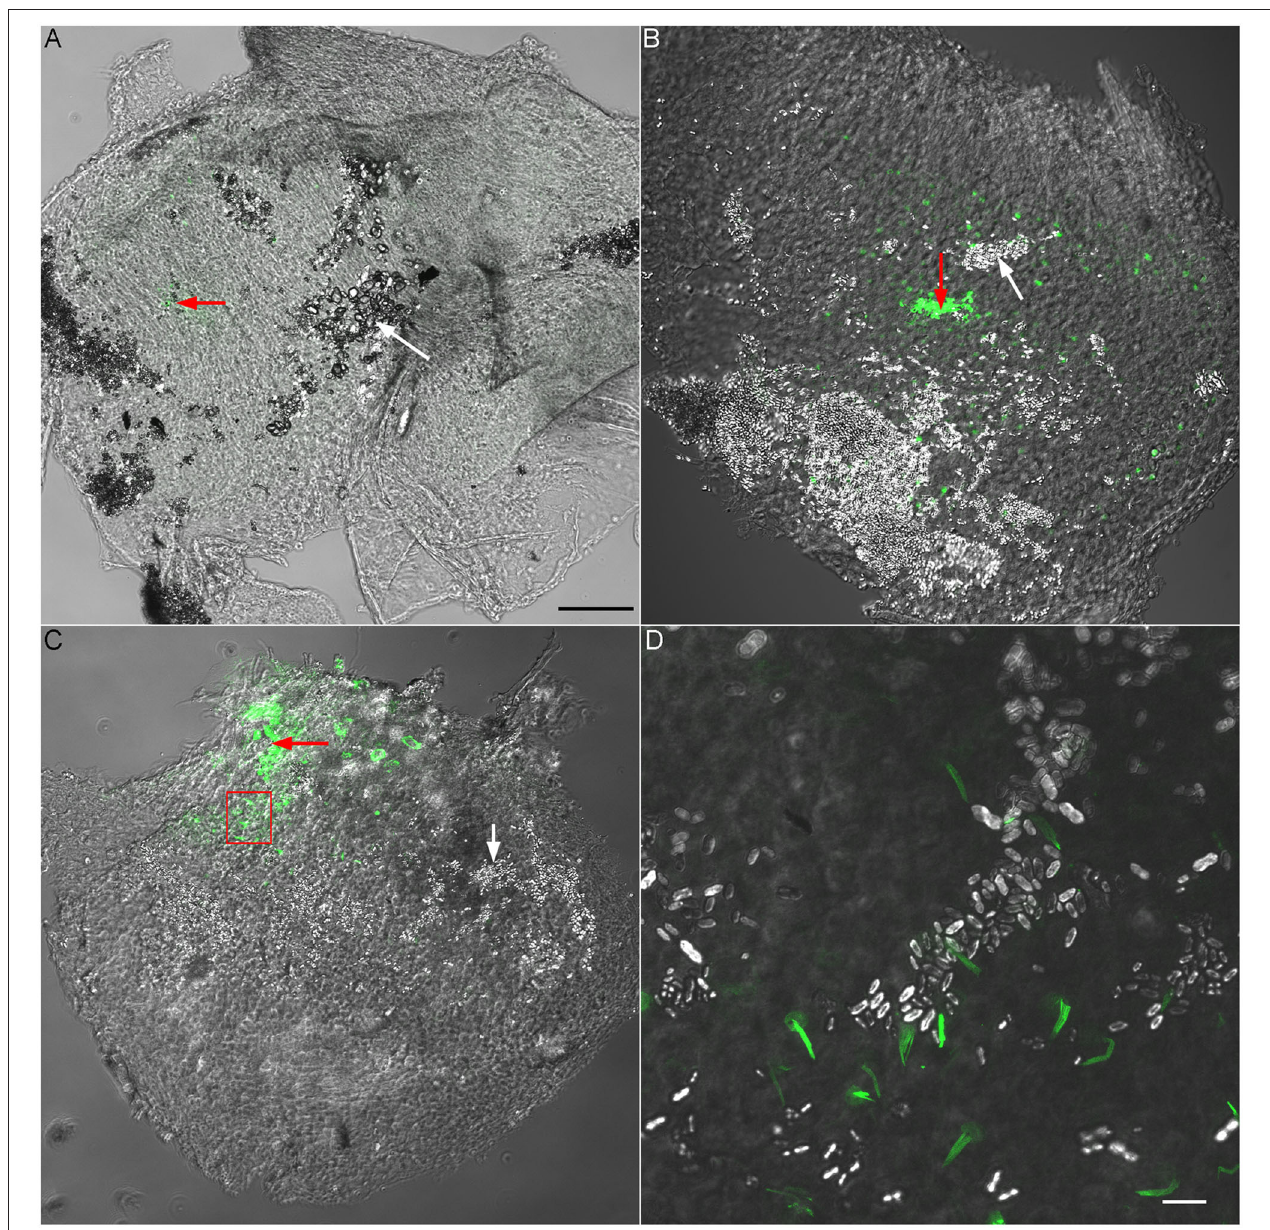
FIGURE 4 | Validation of recording site using fluorescent phalloidin. (A) Superimposed confocal and DIC images (10 × lens) obtained from a P6 utricle. Fluorescent phalloidin was injected to the recording site by applying a positive pressure to the recording electrode after ELP was recorded. The area with fluorescent signal is marked by a red arrow. A white arrow marks otoconia in a nearby area. Scale bar: 100 µ m [for (A) , (B) and (C) panels]. (B) Superimposed confocal and DIC images of a P6 saccule. A red arrow marks the area with fluorescent signal (recording site) while a white arrow marks otoconia. (C) Superimposed confocal and DIC images from a P30 saccule. The area with a frame is presented in panel D with higher magnification. (D) Superimposed confocal and DIC images (63 × lens) of phalloidin-labeled stereocilia bundles of saccular hair cells. Otoconia can also been seen. Scala bar: 10 µ